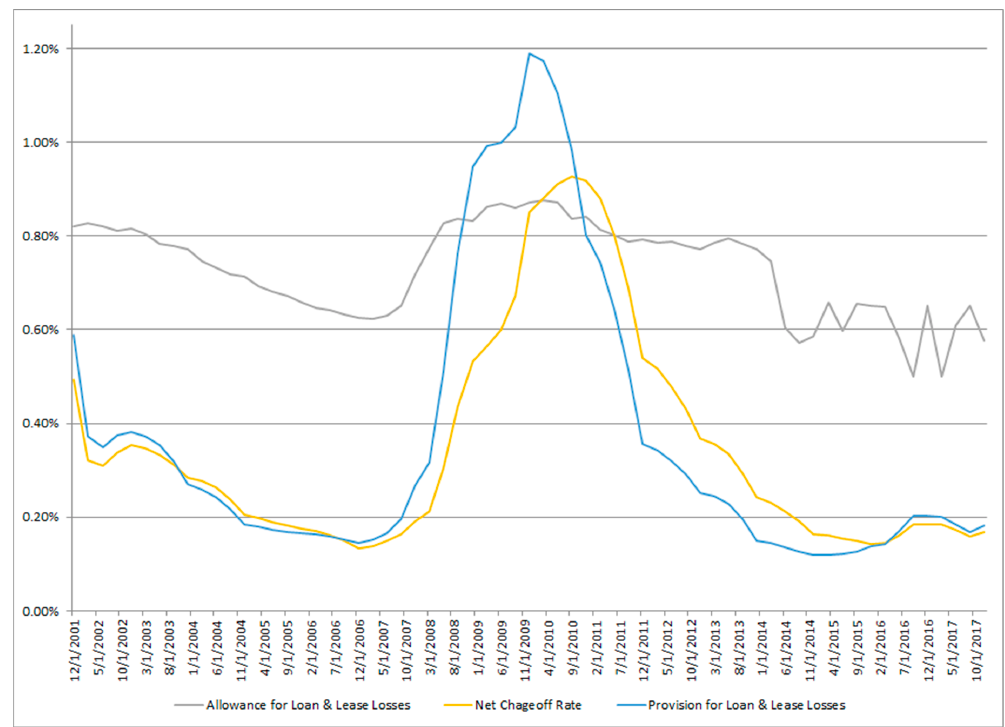
Figure 1. Net Charge-off Rates (NCORs), Provision for Loan and Lease Losses (PLLL), and the Allowance for Loan and Lease Losses (ALLL) as a percentage of total assets—all insured depository institutions in the United States (US) (Federal Deposit Insurance Corporation Statistics on Depository Institutions Report—Schedule FR Y-9C).